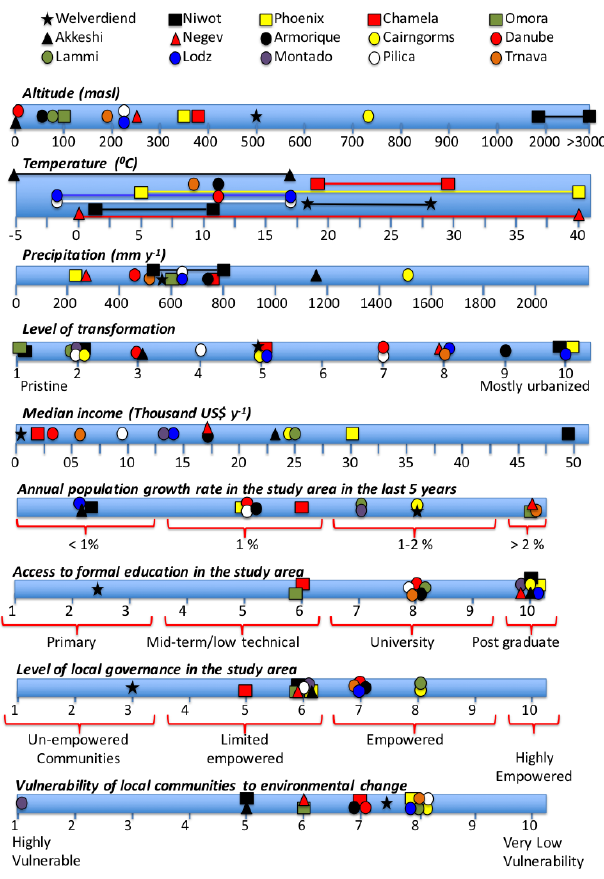
Fig. 3 . Social-ecological heterogeneity of the 15 International Long-Term Ecological Research networks (ILTER) identified as potential participants in a ILTER/Programme on Ecosystem Change and Society (PECS) project. For more information of the sites, please refer to Tables 1 and 2. Marker’s shape refers to site’s continent (star is Africa, squares are Americas, triangle is Asia, and circles are Europe).